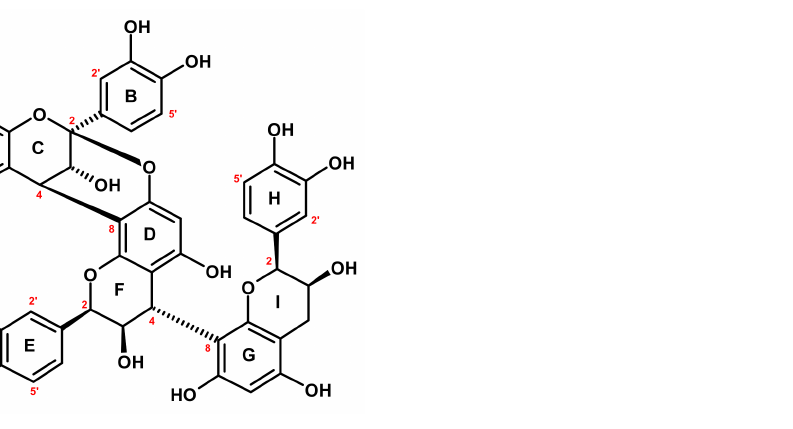
Figure 2. Structure of the isolated procyanidin trimer CB1 (cinnamtannin B-1). Atom numbering in